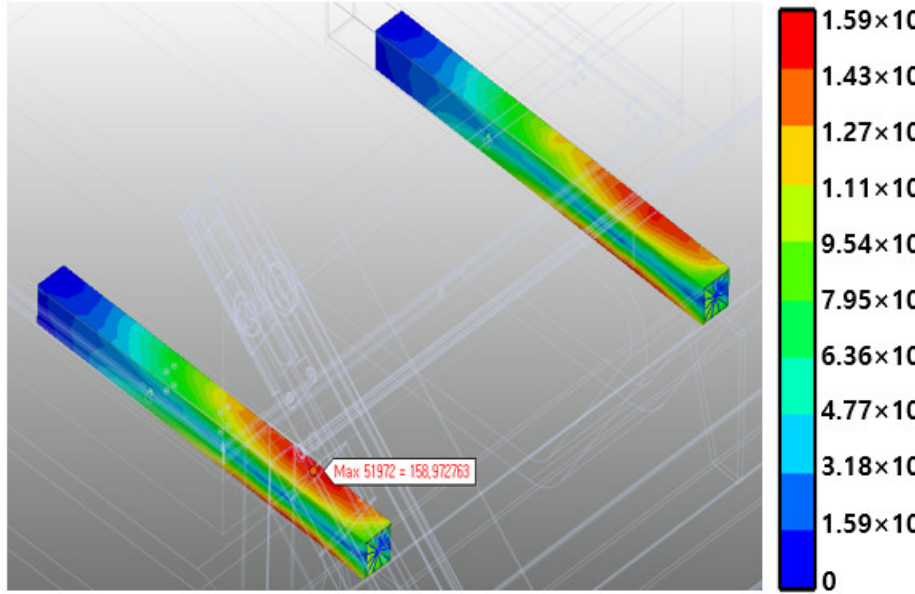
Figure 5. Maximum stress generated on the fastening device.